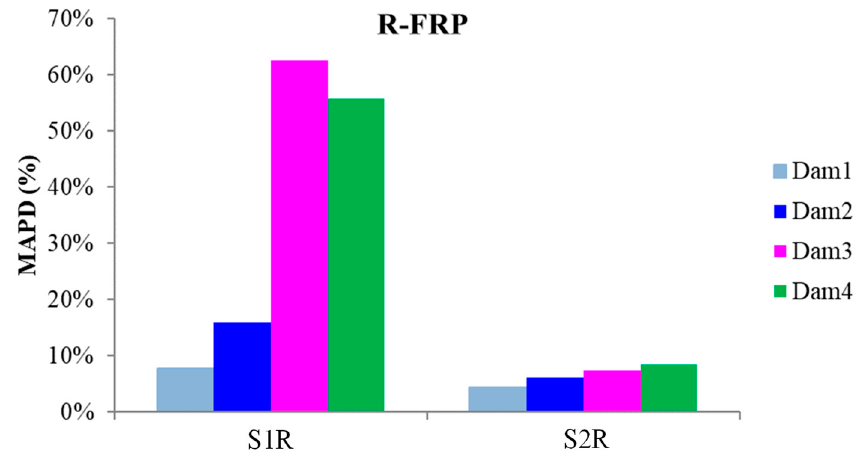
Figure 16. MAPD index values of PTZs mounted on the steel reinforcing bar of R-FRP.